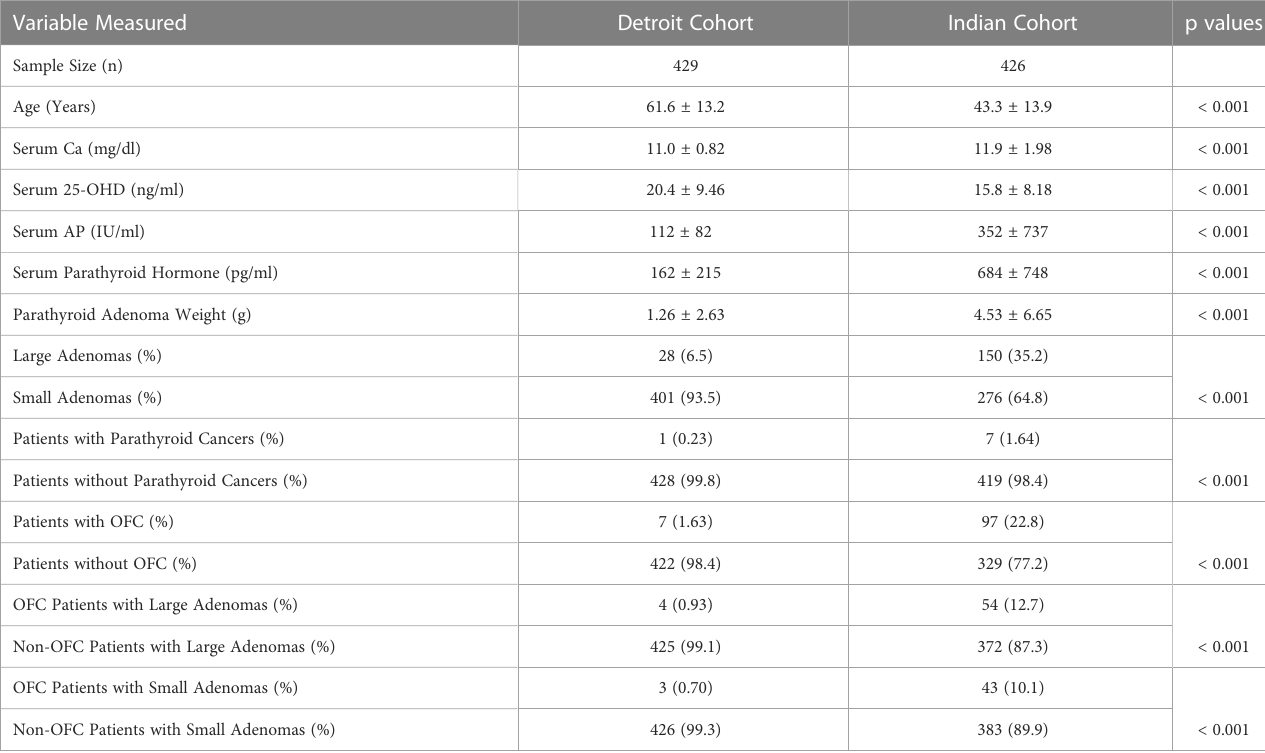
TABLE 2 Comparison of biochemical and parathyroid adenoma characteristics and the prevalence of osteitis fi brosa cystica in the two secularly diverse cohorts (Detroit, USA and Chandigarh, India). Variable